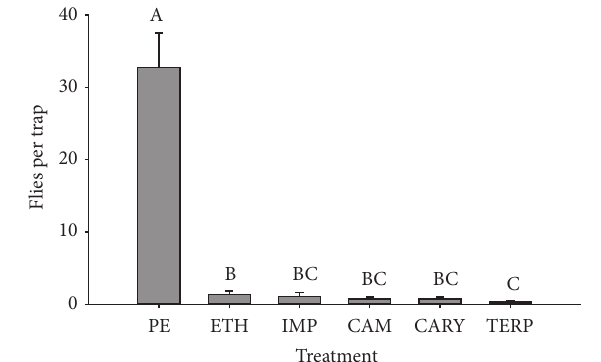
Figure 2: Mean number of adult Homoneura bispina per sticky trap ( ± SE) baited with volatile chemical from Aug 2 to Aug 4, 2004, in a corn plot near Brookings, SD (test #1). Bars without the same letter above have means that differ significantly. PE = 2-phenylethanol, ETH = ethanol (control), IMP = 2-isopropyl-3- methoxypyrazine, CAM = camphor, CARY = trans -caryophyllene, and TERP = terpineol, each at 100 mg on a cotton roll. Homoneura bispina , corn,